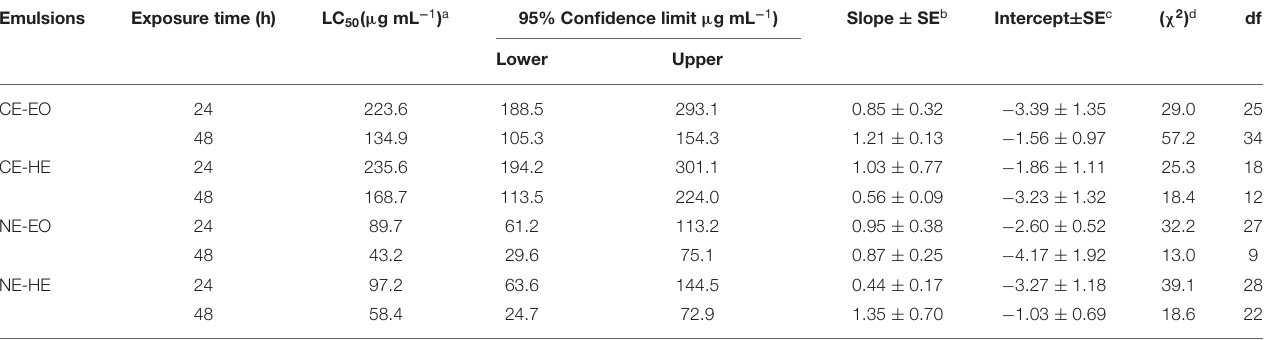
TABLE 3 | Contact toxicity of CEs and NEs against the adults of T. urticae after 24 and 48h of treatment.